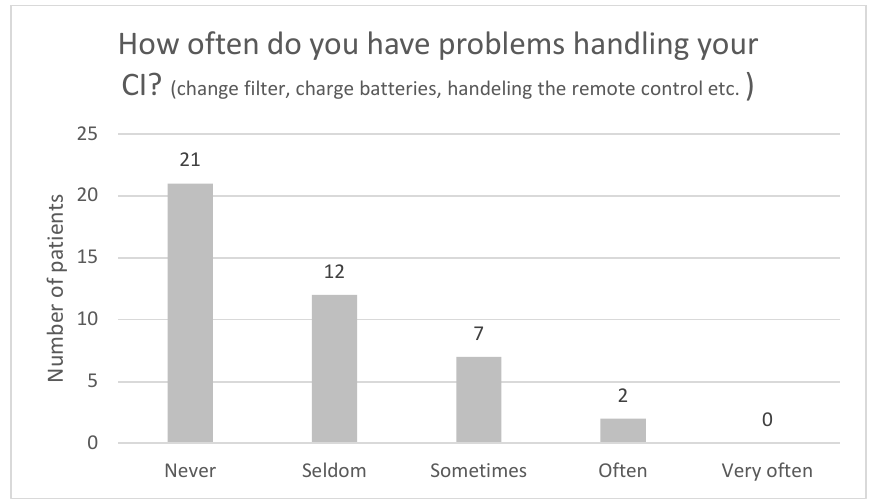
Figure 7. How often do you have problems handling your